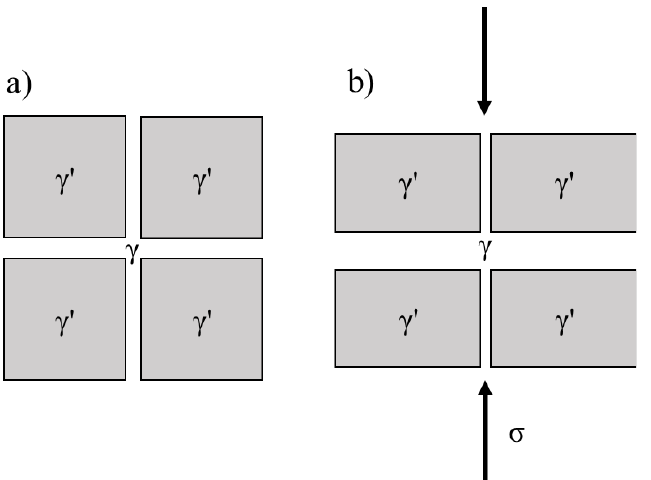
Figure 6. γ/γ’ microstructure ( a ) prior to and ( b ) following compressive stress input (black arrows) from LP illustrating the deformation of the γ and γ’ phases effect.